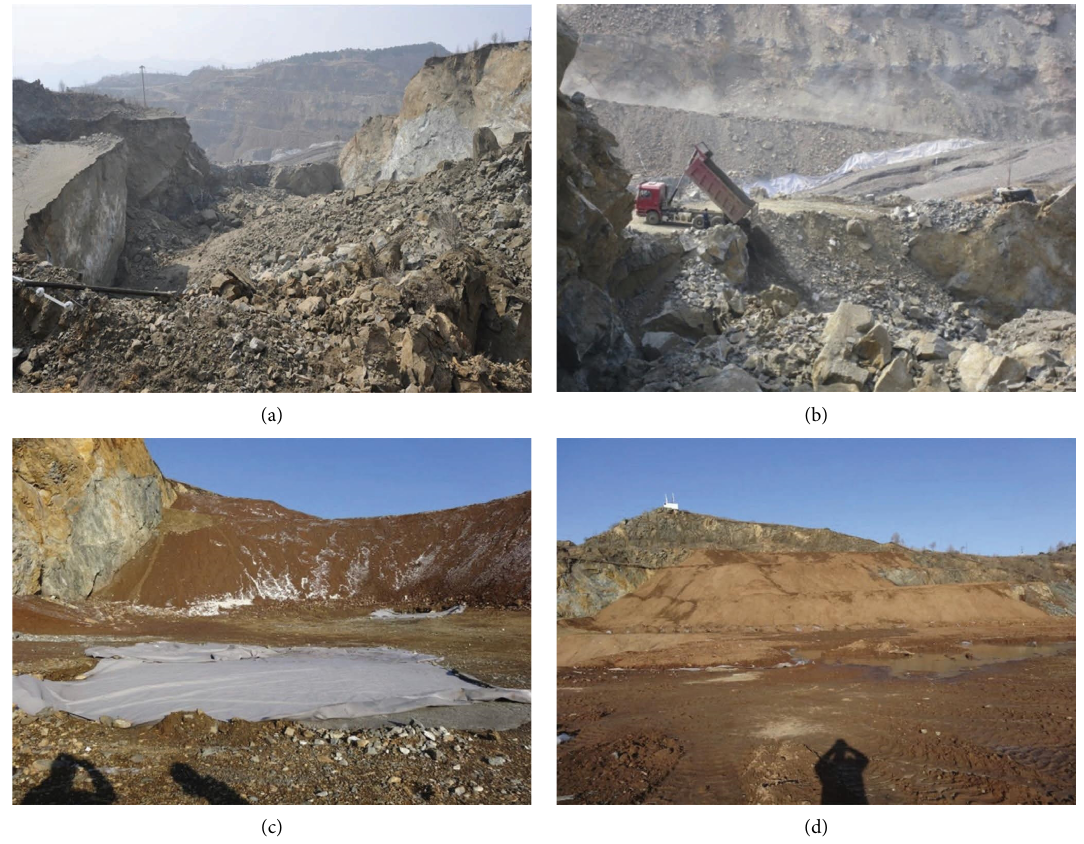
Figure 5: Cover of surface subsidence pit. (a) Surface subsidence pit. (b) Filling process. (c) Covering process. (d) Covering